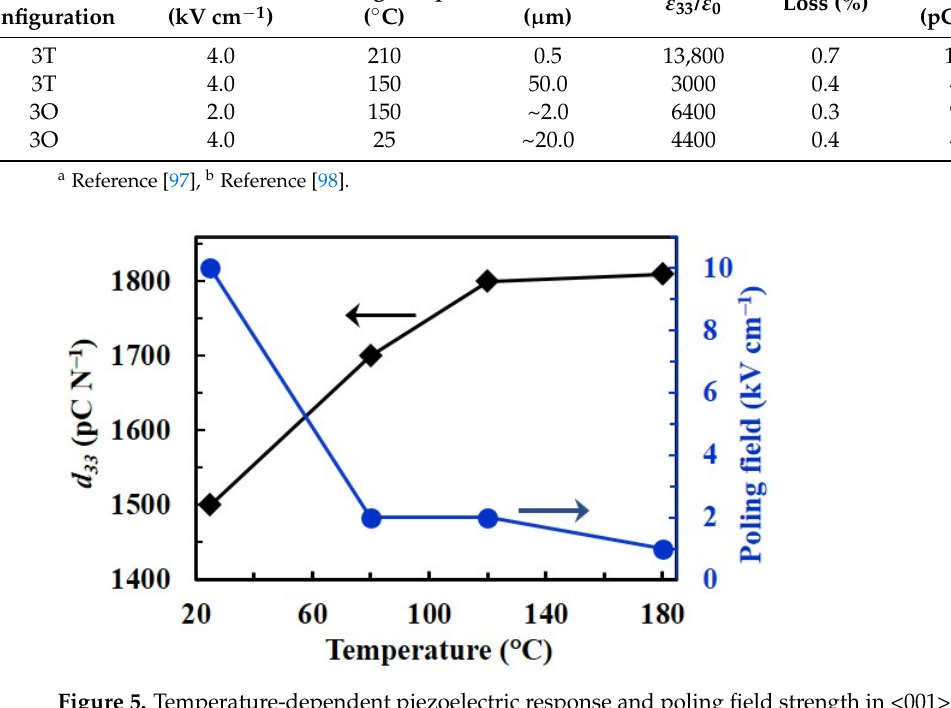
Figure 5. Temperature-dependent piezoelectric response and poling field strength in <001>-oriented PMN-30PT single crystal. Data from ref. [76].